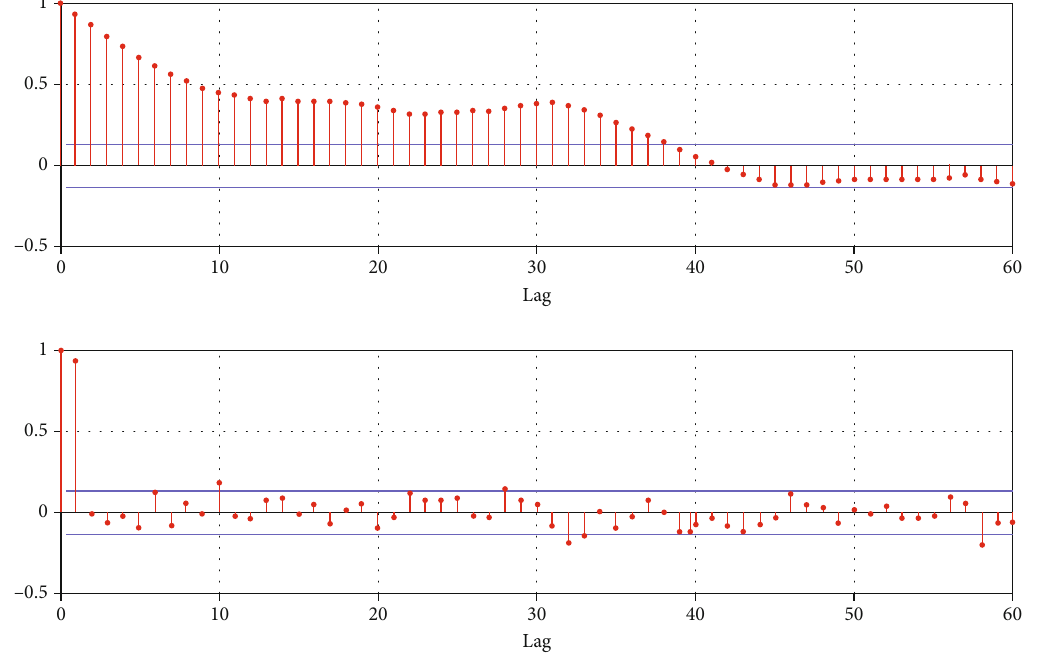
Figure 4: Autocorrelation output.